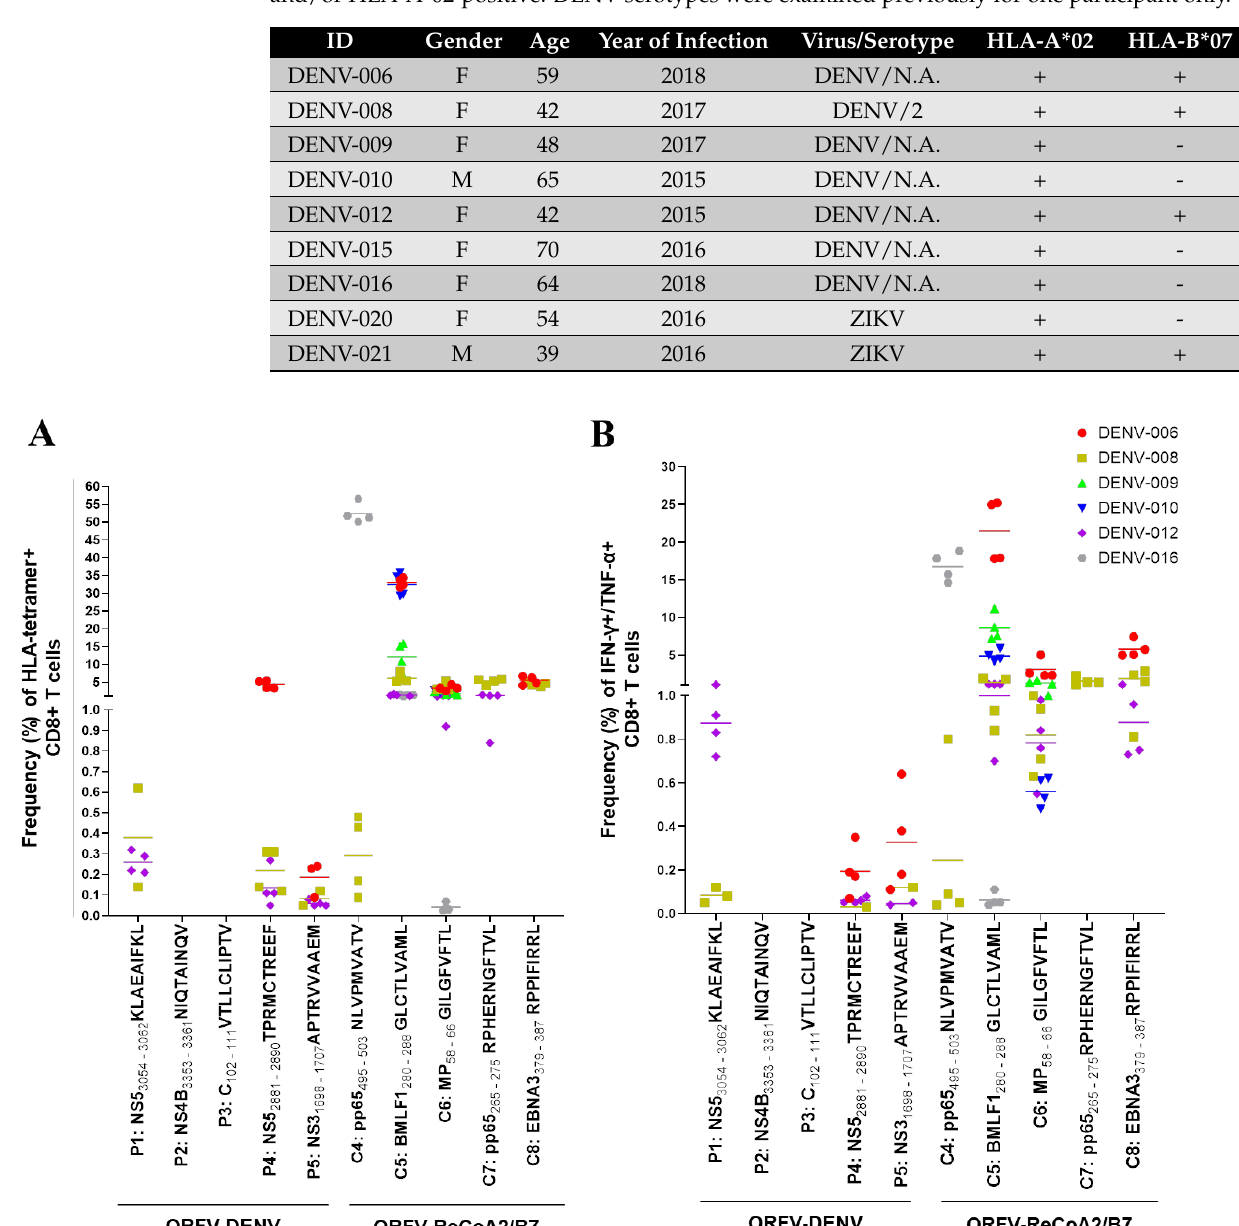
Figure 4. Restimulation of CD8 + T cells from six confirmed DENV-positive donors with ORFV-DENV. The responses of each donor are identified with a different symbol and color, as shown. Each symbol corresponds to a biological replicate exhibiting a positive response. Specific CD8 + T cell activation was verified by ( A ) HLA tetramer staining and/or ( B ) ICS. PBMCs from donor DENV-015 showed no specific CD8 + T cell responses against any of DENV-derived or control epitopes after restimulation (data not shown).